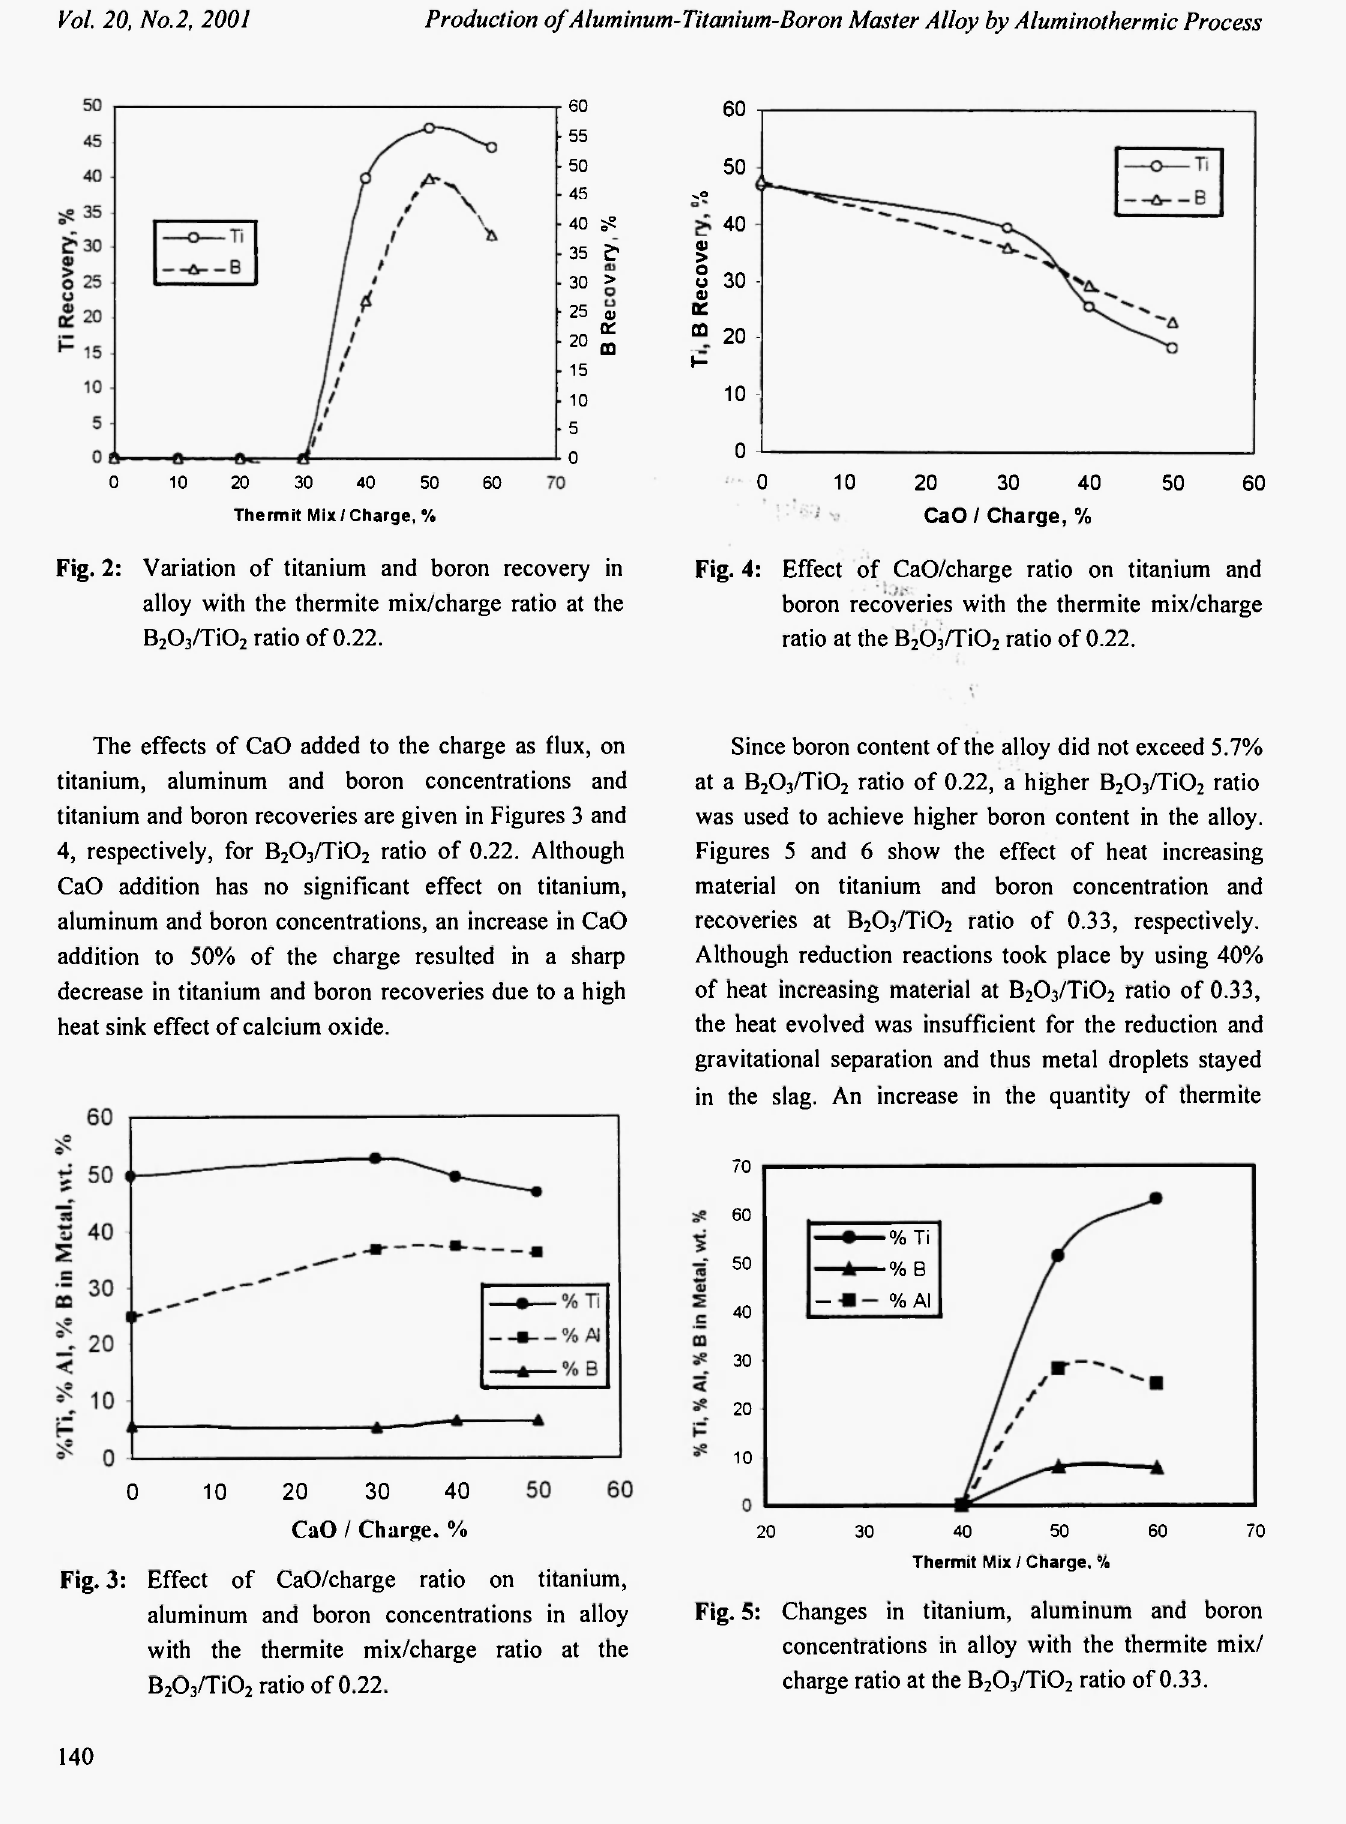
Fig. 5: Changes in titanium, aluminum and boron concentrations in alloy with the thermite mix/ charge ratio at the B 2 0 3 /Ti0 2 ratio of